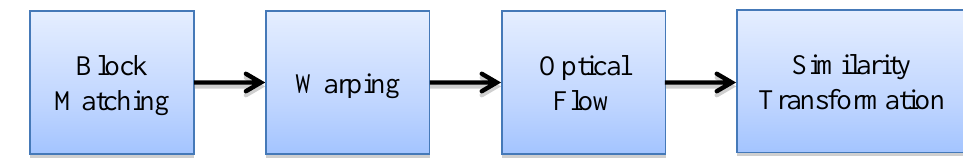
Figure 3. Similarity transformation given the motion vectors obtained with the hybrid BM-optical flow